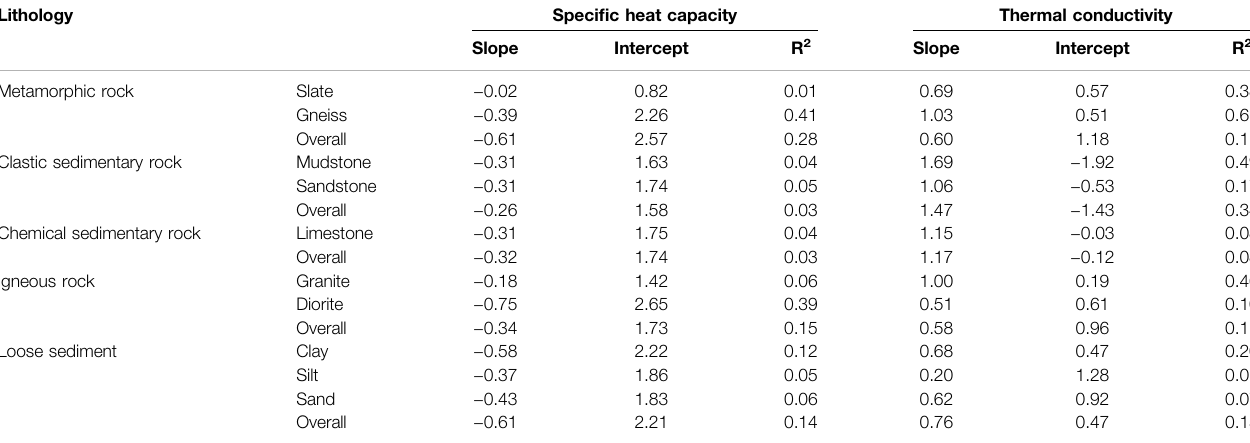
TABLE 3 | Regression analysis results for thermophysical properties and